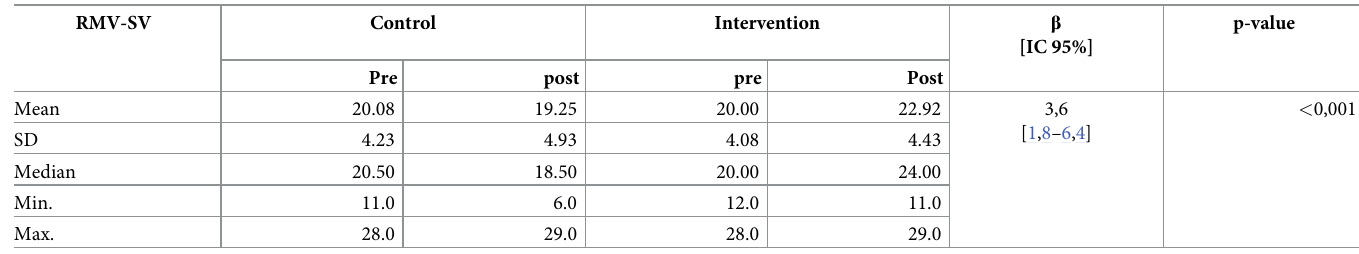
Table 6. Linear regression analysis.